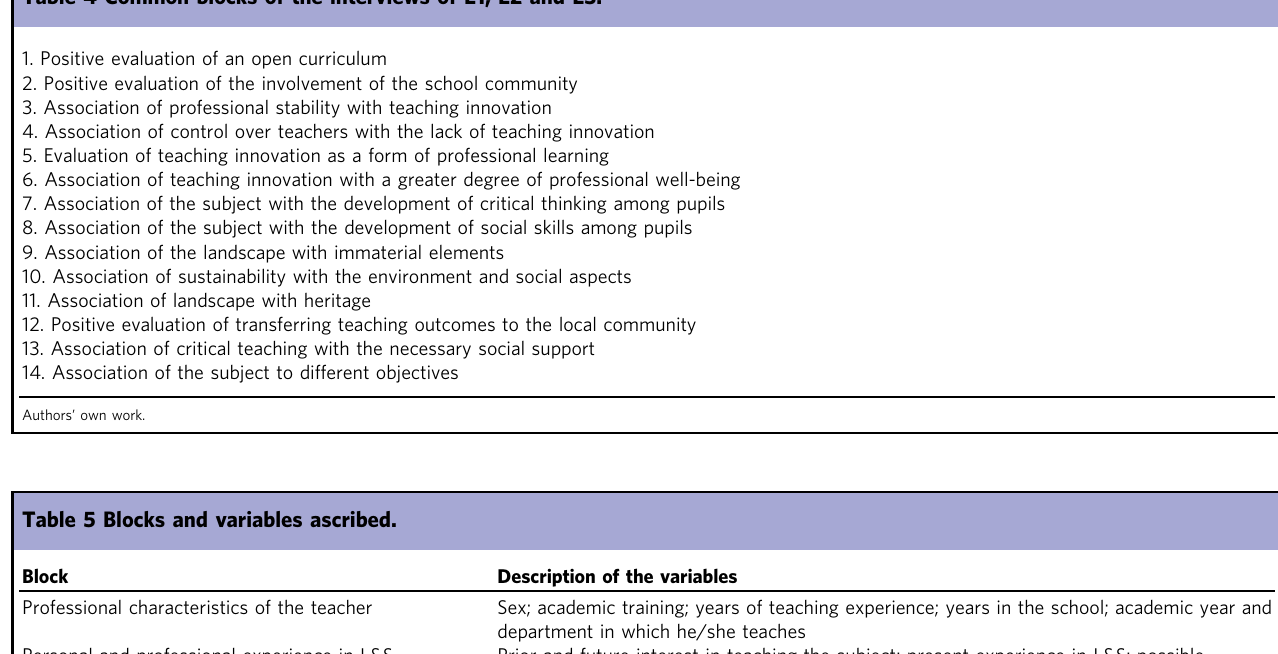
Table 4 Common blocks of the interviews of E1, E2 and E3.